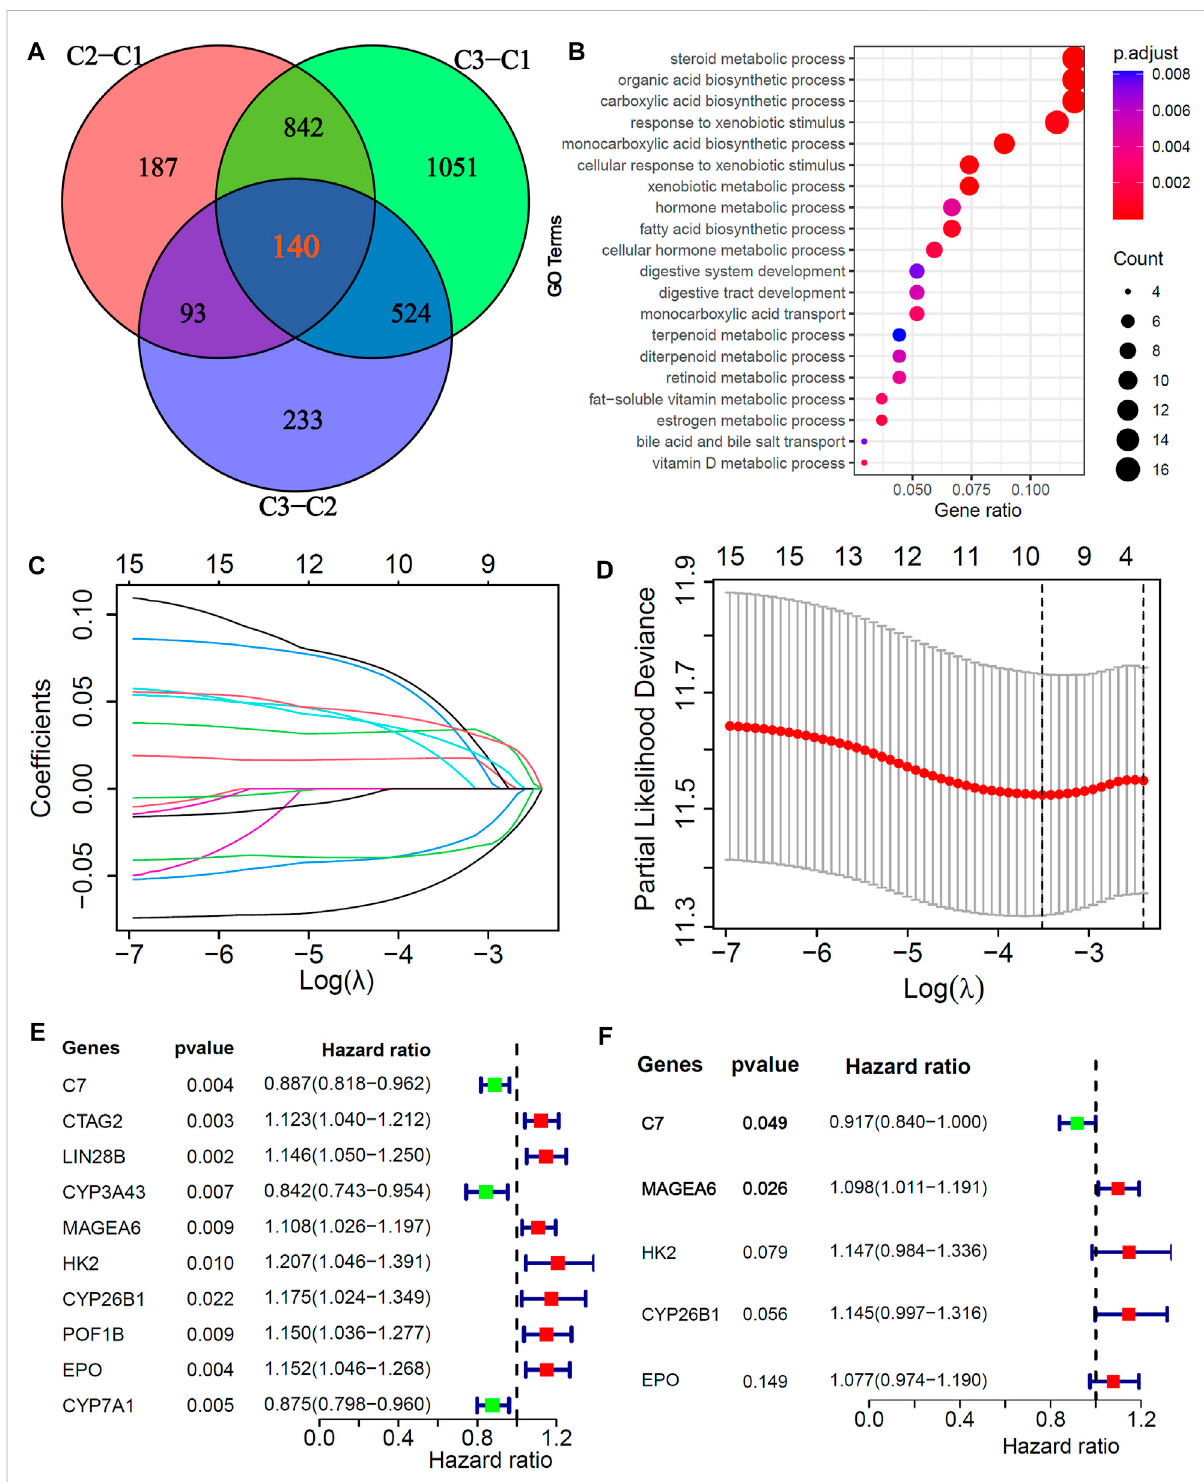
FIGURE 3 Screening of Cu-DEGs and construction of cuproptosis-related prognostic signatures (Cu-PS) (A) The Venn diagram illustrated the 140 Cu- DEGs among three cuproptosis-clusters. (B) GO enrichment analysis revealed the biological characteristics of the 140 DEGs. (C) 10 Cu-DEGs screened by LASSO regression. (D) 10-fold cross-validation plot of LASSO regression. (E) Univariate Cox forest-plot of the 10 selected Cu-DEGs. (F) Forest-plot of 5 hub Cu-DEGs in Cu-PS identi fi ed by multivariate Cox regression